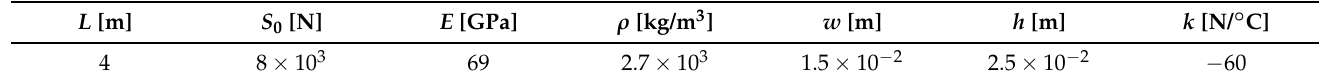
Table 1. Parameters of the simulated tie-rod.